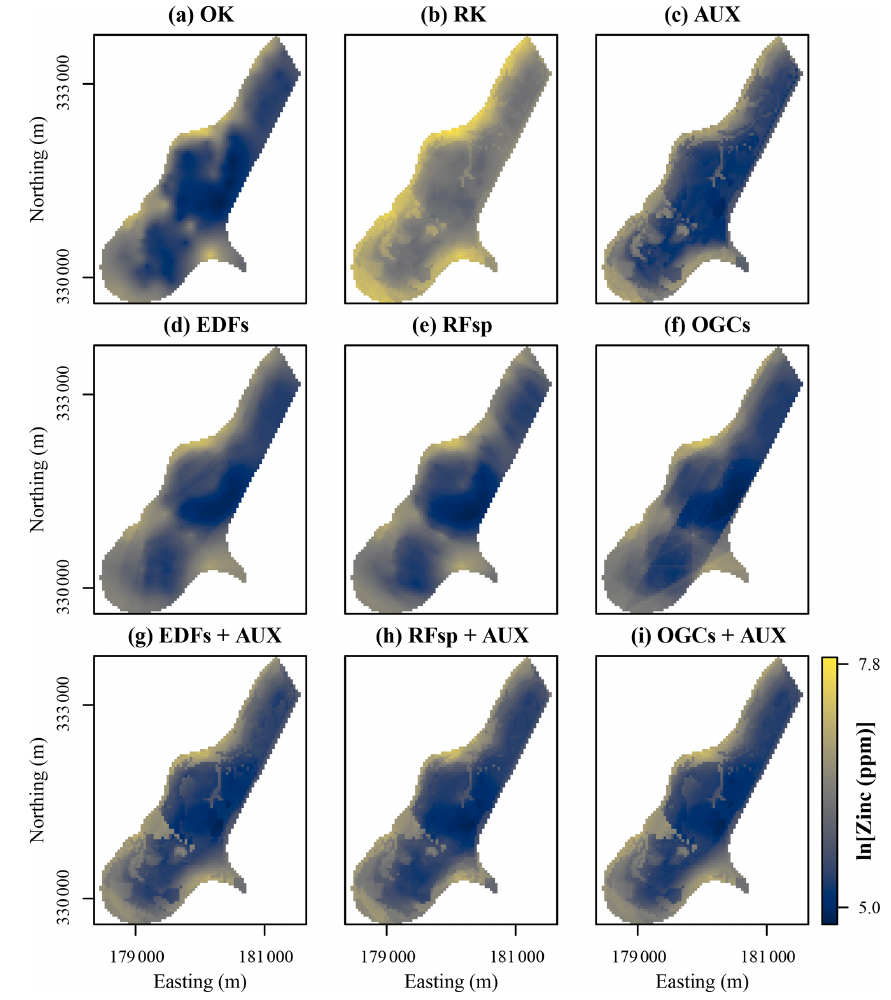
Figure 9. Zinc contents predicted with each method for the meuse dataset. Easting and northing are Rijksdriehoek (RDH; Netherlands topographical map) coordinates. (a) Ordinary kriging (OK), (b) regression kriging (RK), (c) auxiliary data (AUX), (d) Euclidean distance fields (EDFs), (e) distances to observations (RFsp), (f) oblique geographic coordinates (OGCs), (g) EDFs combined with AUX, (h) RFsp combined with AUX, and (i) OGCs combined with